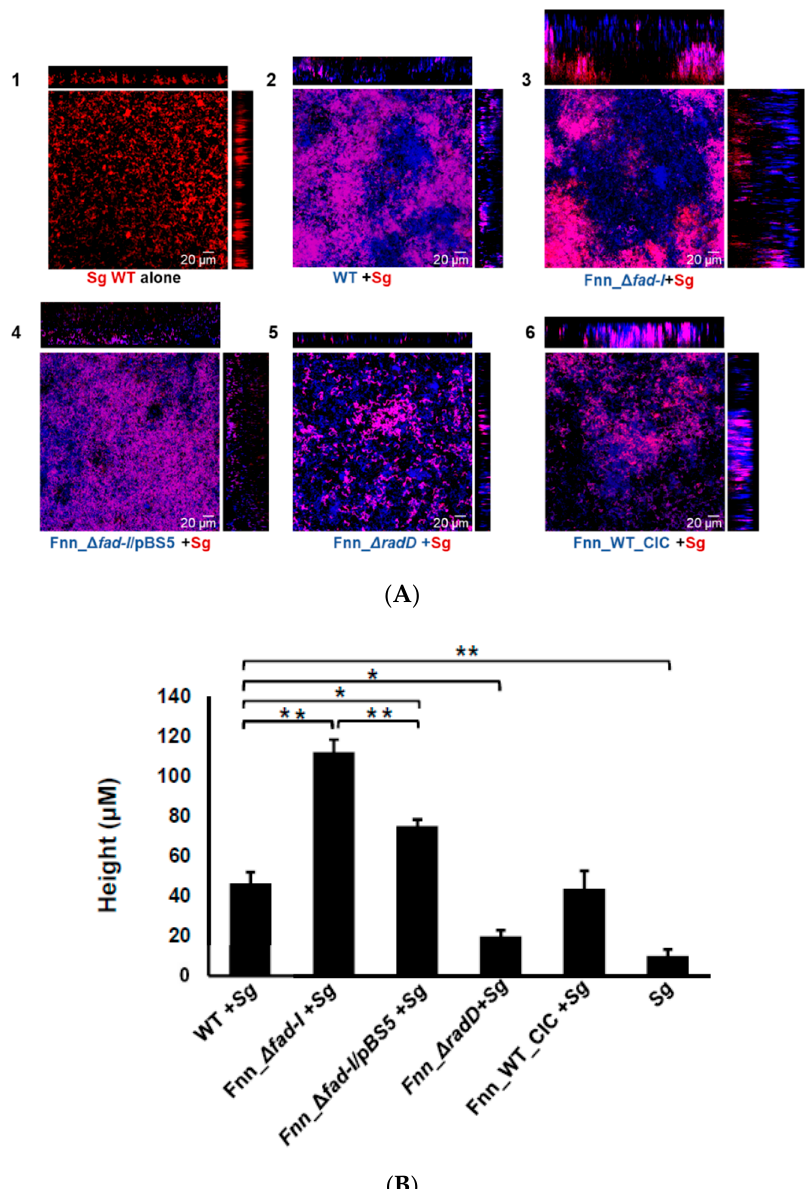
Figure 8. ( A ) . Visualization of dual-species biofilm formed between wild-type and mutant strains of F. nucleatum ssp nucleatum ATCC 23726 and S. gordonii (mCherry) by CLSM. The biofilm was fluorescently labeled with SYTO9. The S. gordonii (Sg) cells constitutively express mCherry and appear red on the images. Wild-type (WT) F. nucleatum (Fn) and its mutants ( fad-I, fad-I/pBS 5, radD , WT-CIC ) are stained by syto9-only which are pseudo-colored as blue in the Zen software. Association of F. nucleatum and S. gordonii in the biofilm is observed as purple color in the confocal images. Each image panel is represented by x-z axis view on top and y-z axis view on the right side of the x-y view. The various panels show the biofilm formed by: ( 1 ) S. gordonii (Sg) alone; ( 2 ) wild-type ATCC 23726 with S. gordonii; ( 3 ) Fnn_ ∆ fad-I with S. gordonii; ( 4 ) Fnn_ ∆ fad-I / pBS5 with S. gordonii ; ( 5 ) Fnn_ ∆ radD with S. gordonii; ( 6 ) Fnn_WT_CIC with S. gordonii . ( B ) Comparison of the height of the dual species biofilm of the wild-type and mutant strains of F. nucleatum ssp nucleatum ATCC 23726 with S. gordonii , as observed from the confocal images. The data represents mean of the height and standard error of mean of biofilm as observed in three independent experiments with height measurements captured in five randomly chosen locations in each experiment (n = 15). The single species biofilm of S. gordonii is also included as control. (* represents p ≤ 0.05, ** represents p ≤